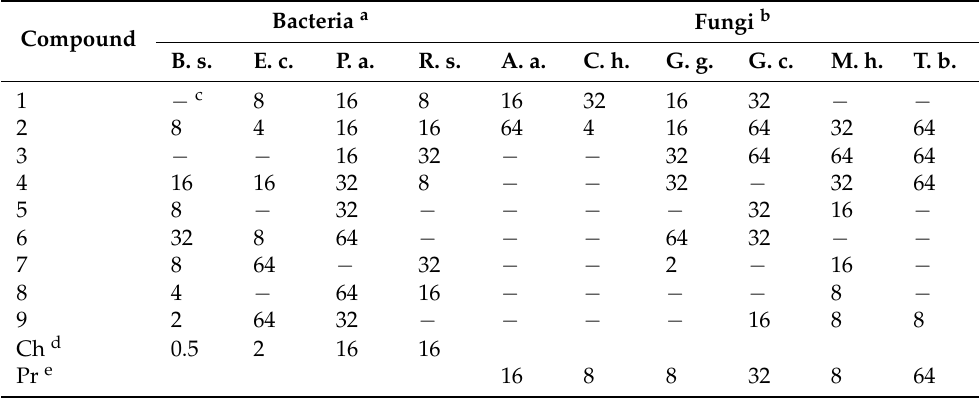
Table 2. Minimum inhibitory concentration (MIC, µ g/mL) of compounds 1 – 9 against human- and plant-pathogenic